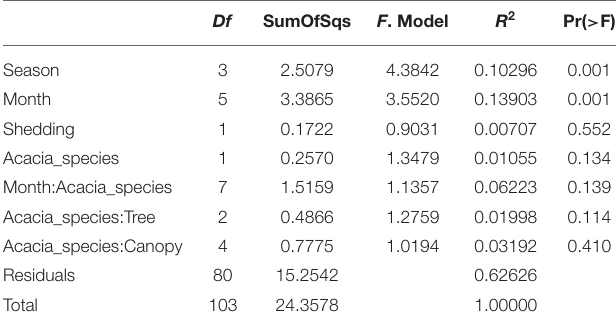
TABLE 2 | PERMANOVA analysis showing statistical significance of epiphytic microbial communities across sampling months, season, tree phenology (leaves shedding period), and canopy sides.